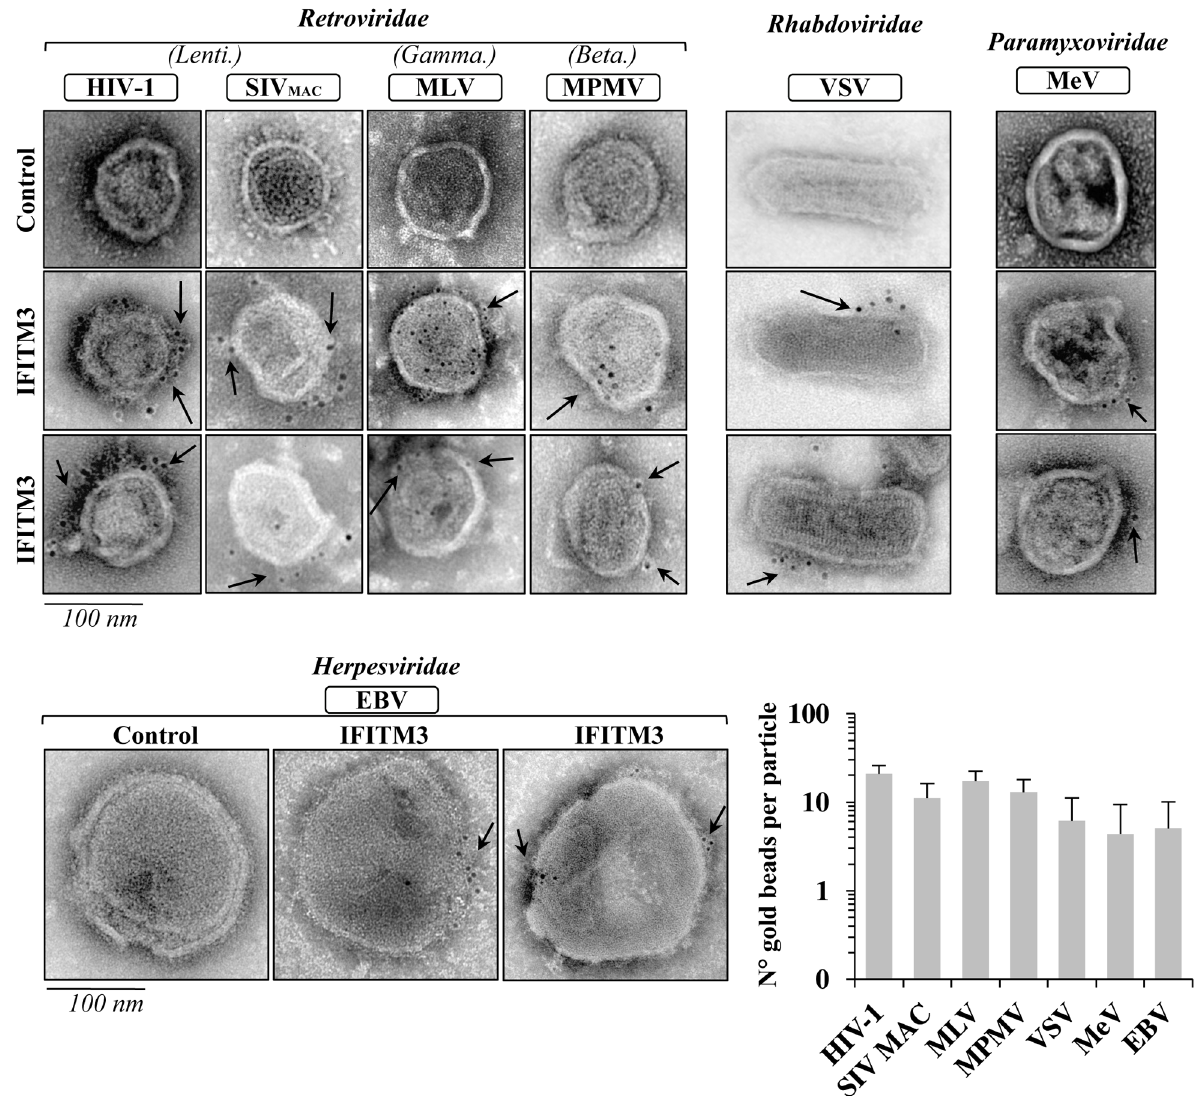
Fig 3. IFITM3 is a bona fide virion-associated protein. Virion particles producedas describedabovewere then analyzedby immuno- gold electronmicroscopy.Briefly, unfixed viral preparations purifiedby ultracentrifugationand producedin the presence or absenceof IFITM3 were incubatedwith anti-Flag antibodies, followedby incubation with a gold-conjugated secondary antibody (arrows). Representative pictures are shown here. The graph displaysthe number of gold particles countedon a per virion basis.